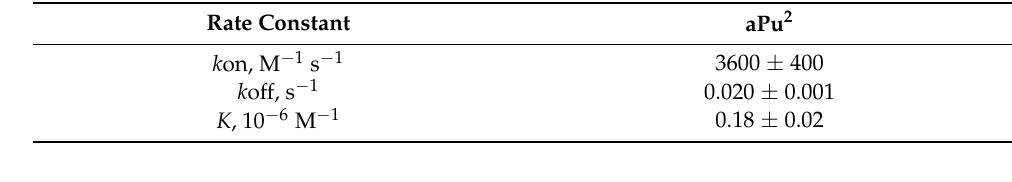
Figure 6. Changes in the fluorescence intensity of aPu during the interaction between Nfo and aPu 2 ( a ). The Nfo concentration dependence of the observed rate constant ( b ). [aPu 2T ] = 1.0 μ M; Nfo concentration varied between 1.0 and 6.0 M.